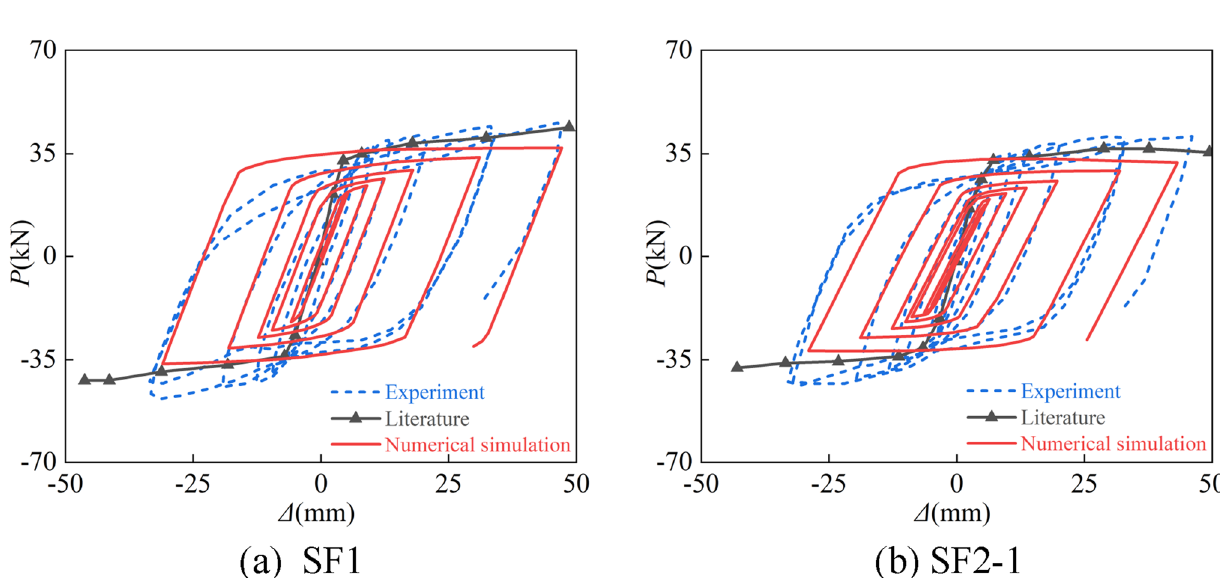
Figure 5. P- Δ hysteresis curves after exposure to